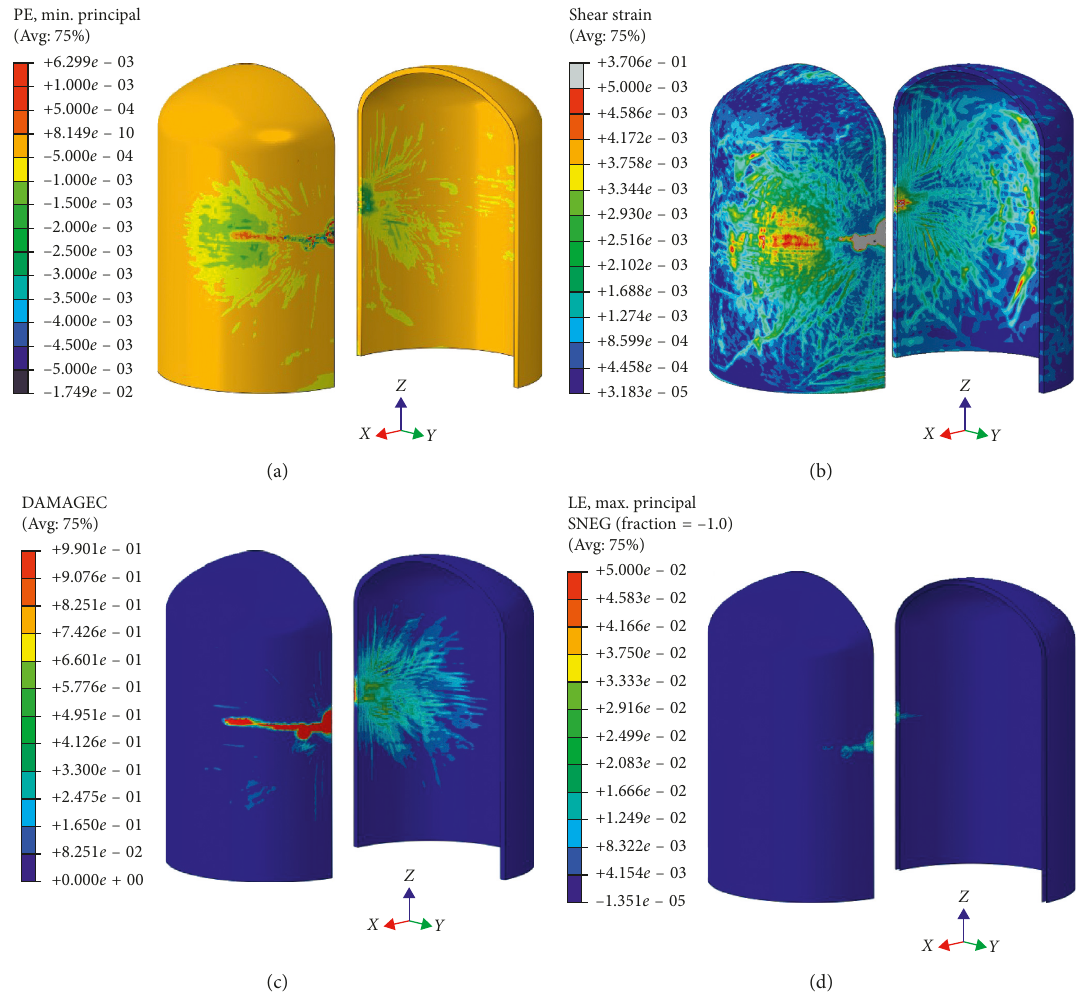
Figure 17: Numerical results of Boeing 767-200ER crash on the containment (WT case, 0.25 s). (a) Compressive strain in the concrete. (b) Shear strain in the concrete. (c) Compressive damage in the concrete. (d) Tensile strain in the reinforcement. PE, min. principal (Avg: